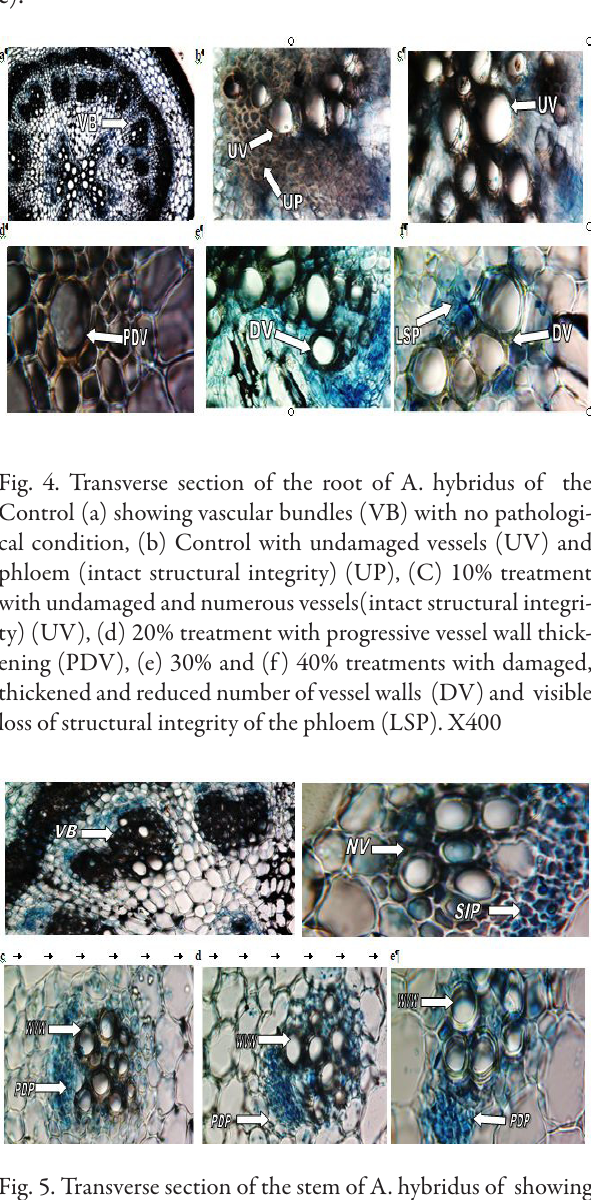
Fig. 5. Transverse section of the stem of A. hybridus of showing (a) the Control with intact vascular bundles, (b) 10% treatment with normal vessels (NV) and structurally-intact phloem (SIP), (c) 20%, (d) 30% and (e) 40% treatments with wide-vessel walls (WVW) and loss of structural integrity and pathological death of the phloem (PDP). X400